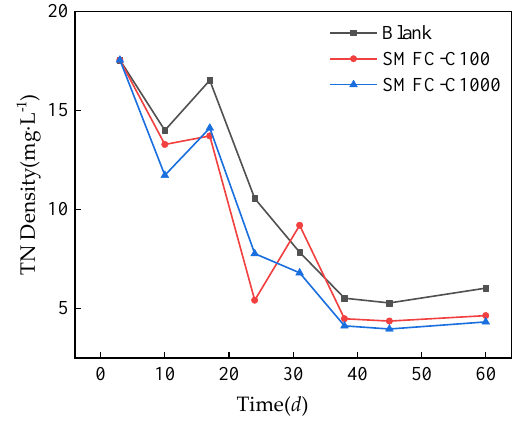
Figure 6. TN concentration curves.